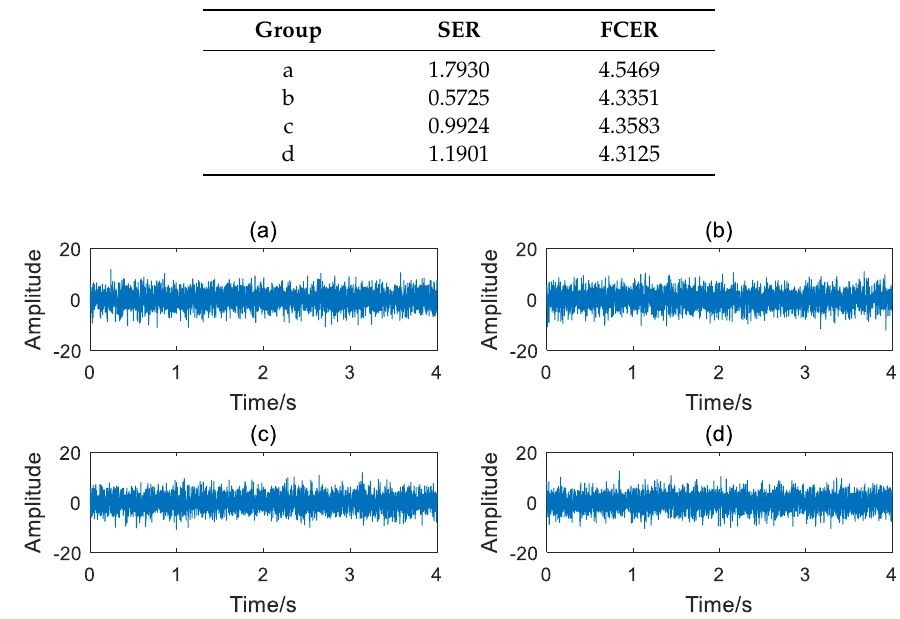
Table 2. The results of SER and FCER for the simulation signal.